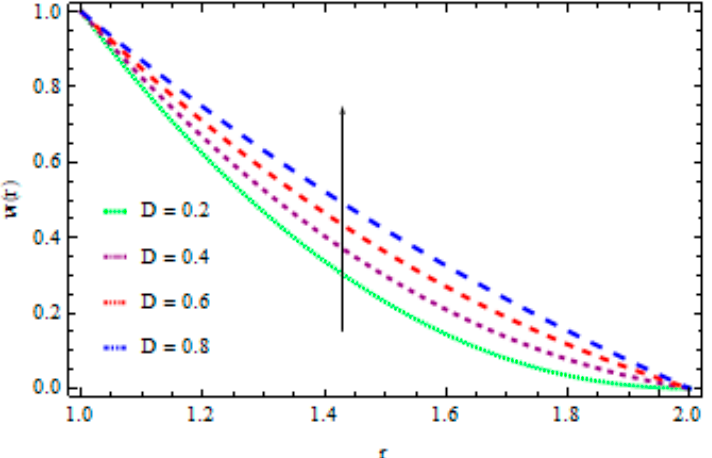
Figure 7. The influence of Q on velocity distribution for Vogel’s model when 0.2, ' 1.0,